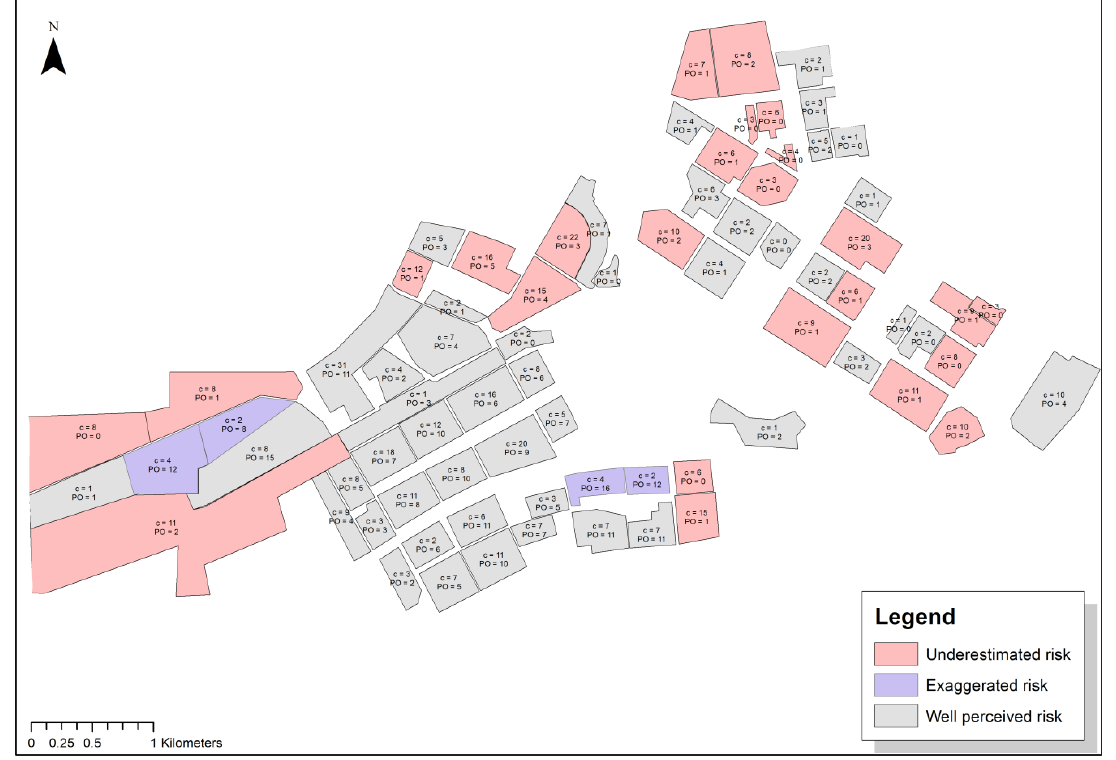
Figure 5. The number of crimes (c) in atoms and the number of police officers (PO) who marked at least one location within the atom.